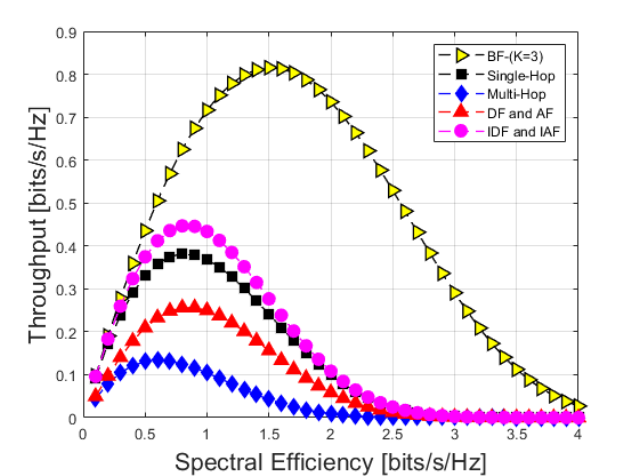
Figure 9. Throughput vs. spectral